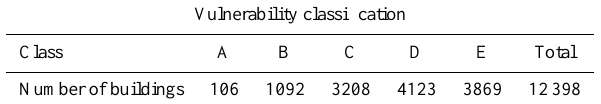
Table 5. Vulnerability classification of the buildings inside the ag- gregate inundation area selected in step 2 of the procedure. It ex- tends over 15km 2 . Data refer to the mean-sea-level case.